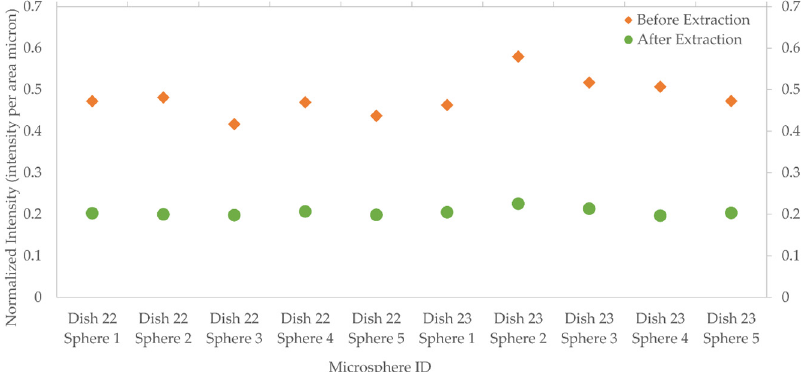
Figure 8. Results of the template removal via chemical extraction. Two different parameters, stage condition, and different solutions were tested. ( a ) and ( b ) shows the results for the tilt tray condition applied to Dish 10 and Dish 21; ( c ) and ( d ) shows the results for the stationary condition applied to Dish 18 and Dish 19. Chemical extraction results were not as expected; in fact, an increase in the fluorescence intensity measurements was observed. Therefore, several extraction parameters and different extraction methods were analyzed. Please note that, in figures ( c ) and ( d ), the pre-extraction data were so low in comparison, they do not show on the graphs.